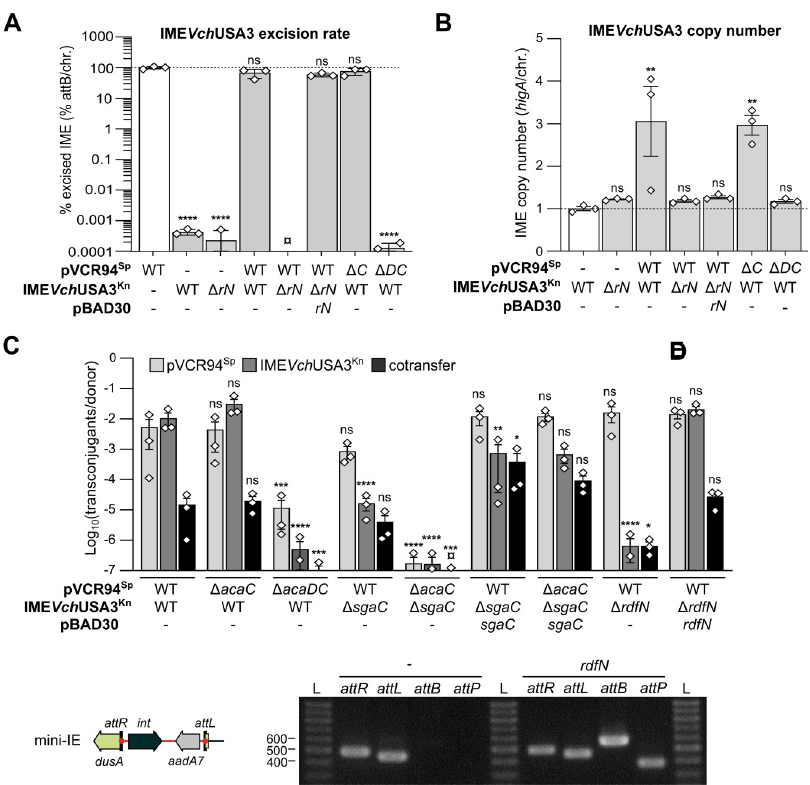
Fig 5. Effect of acaDC and rdfN on the IncC-dependent excision and mobilization of IME Vch USA3. (A) IME Vch USA3 Kn excision rate corresponds to the attB /chromosome ratio. (B) IME Vch USA3 Kn copy number corresponds to the higA /chromosome ratio. For panels A and B, all ratios were normalized using the control set to 1 and displayed in white. (C) Impact of acaC , acaDC , sgaC and rdfN deletions on the mobilization of IME Vch USA3. Conjugation assays were performed with CAG18439 (Tc) containing the specified elements as donor strains and VB112 (Rf) as the recipient strain. The bars represent the mean and standard error of the mean obtained from a biological triplicate. ¤ indicates that the excision rate or transfer frequency was below the detection limit. Statistical analyses were performed (on the logarithm of the values for panels A and C) using a one-way ANOVA with Dunnett’s multiple comparison test. For panels A and B, statistical significance indicates comparisons to the normalization control. Statistical significance is indicated as follows: ���� , P < 0.0001; ��� , P < 0.001; �� , P < 0.01; � , P < 0.05; ns, not significant. (D) Schematic representation of mini-IE inserted at the 5’ end of dusA . (E) RdfN acts as a recombination directionality factor. Detection of attB , attP , attL and attR sites by PCR in colonies of E . coli EC100 dusA ::mini-IE in the presence or absence of rdfN . L, 1Kb Plus DNA ladder (Transgen